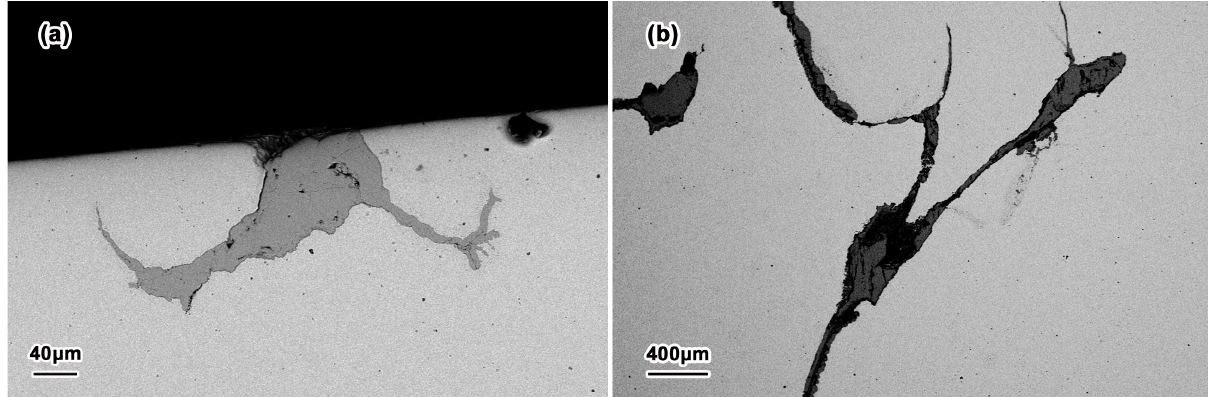
Figure 2: Cross-sectional (a) and polished surface (b) morphology of a reticular crack.